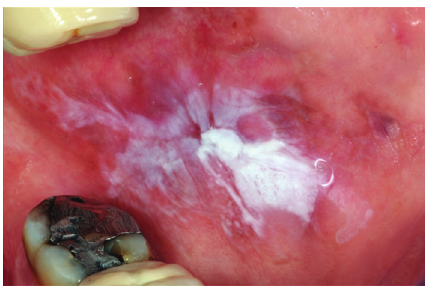
Figure 1: An oral lichenoid lesion or a toxic reaction on buccal mucosa found close to a large amalgam restoration. A positive patch test result to dental materials may confirm this to be an